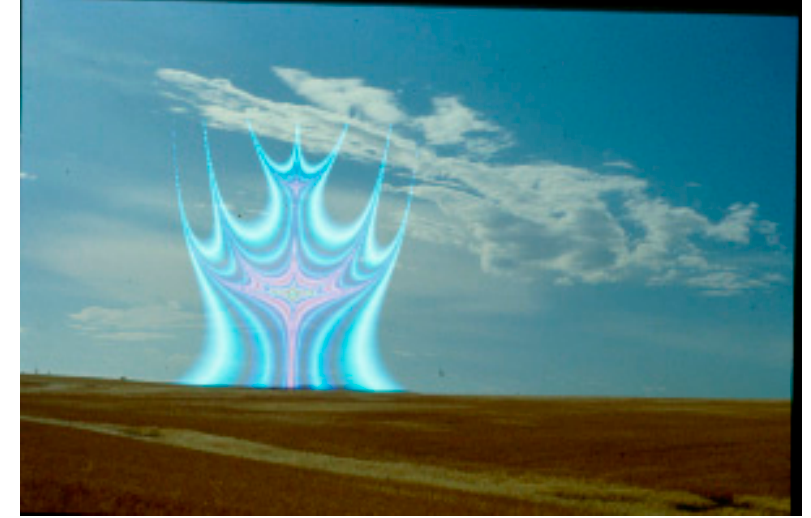
Figure 24. One of Ostoja’s landscapes with CGI. Published with permission. Image courtesy of the State Library of South Australia. SLSA: PRG919/21/159.